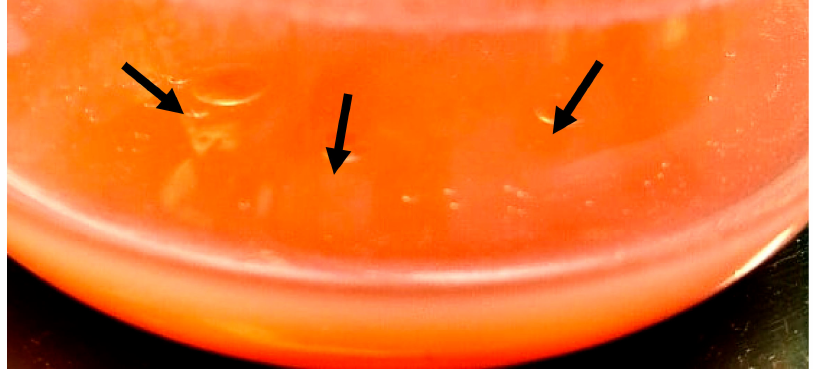
Figure 2. The presence of “oil droples” (black arrows) on the surface of culture medium of the yeast strain Rhodotorula kratochvilovae CCY